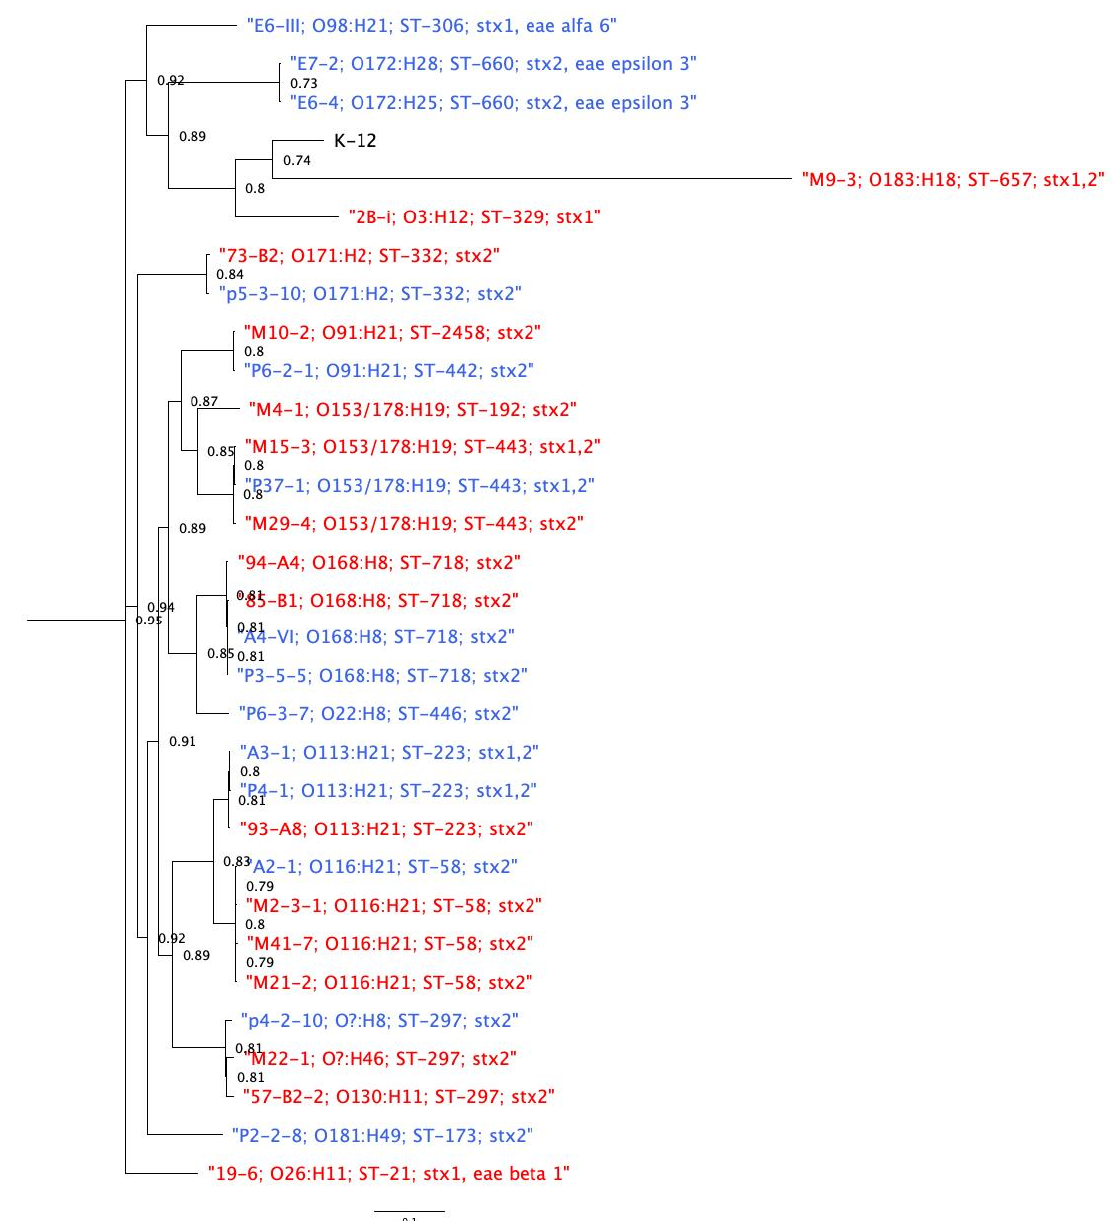
Figure 4. Maximum likelihood phylogeny of STEC isolated from cattle in Chile ( n = 30). The evolutionary history was inferred using the maximum likelihood method using RAxML with SNPs inferred from CSI phylogeny. The tree is drawn to scale, with branch lengths measured in the number of substitutions per site. Bootstrap values are shown. Isolates in red represent southern isolates, and blue represents central isolates. SNP matrix is available in Table S4.